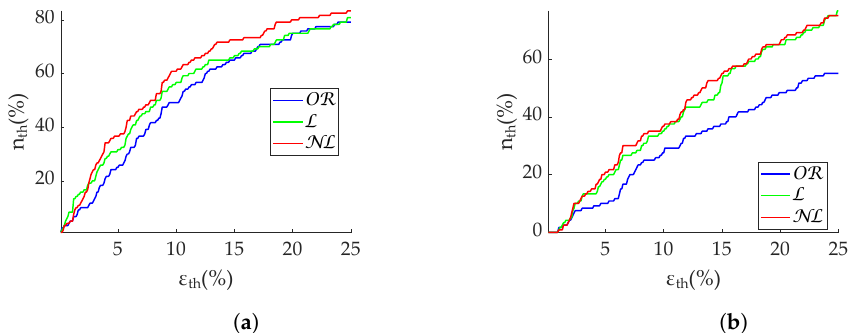
Figure 8. Coverage of frequency-domain metrics computed via Lomb’s method from Apple Watch dataset. ( a ) P LF . ( b ) P HF .